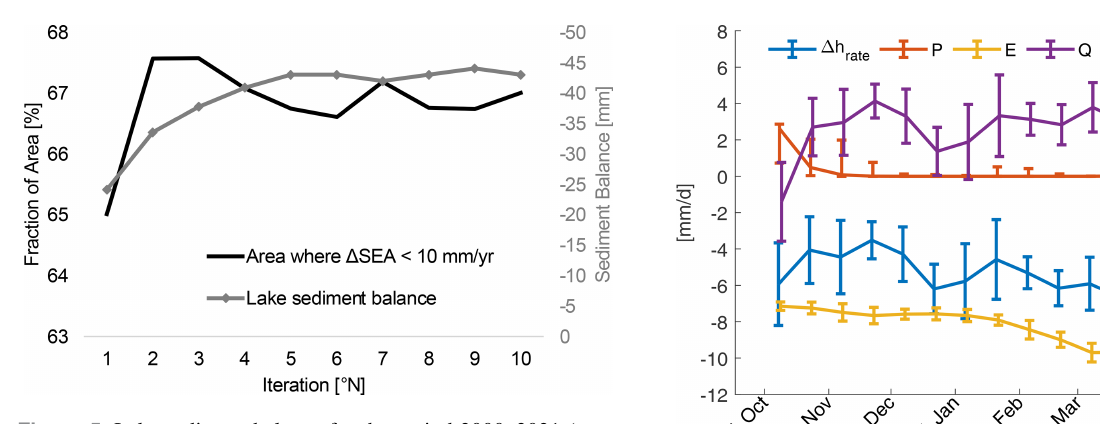
Figure 5. Lake sediment balance for the period 2000–2021 (aver- age (cid:49) SEA within the lake bed) and the fraction of the area where absolute (cid:49) SEA does not exceed 10mmyr − 1 as a function of the iteration number.